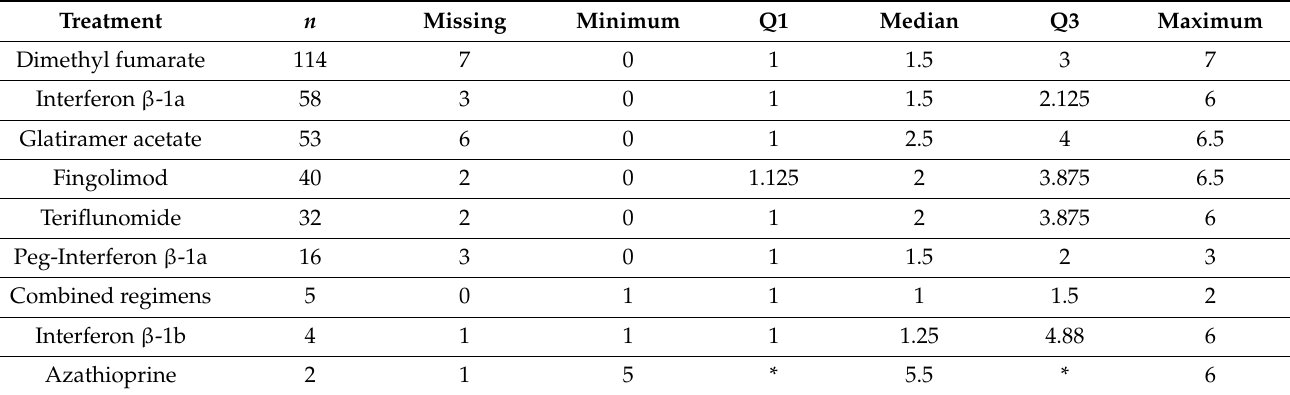
Table 2. Distribution of EDSS score’s values according to the type of DMD.